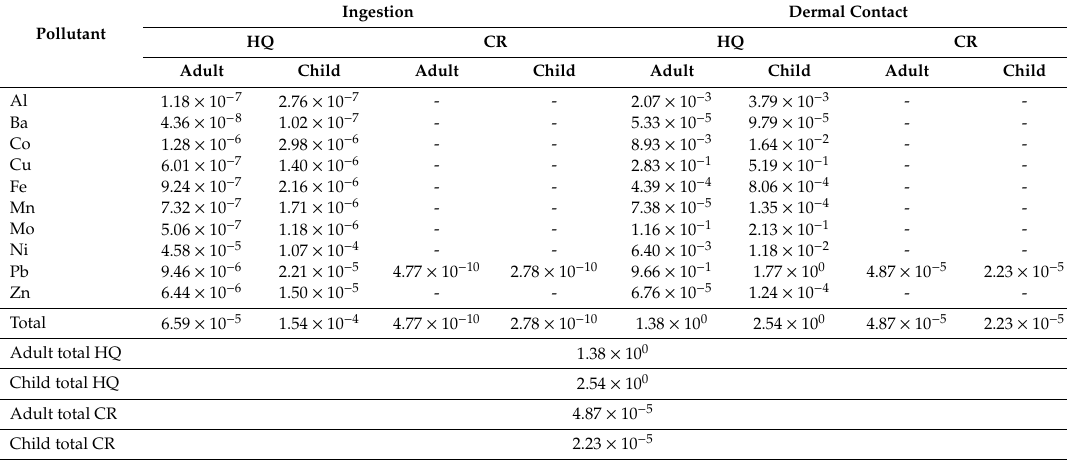
HQ—hazard quotient; CR—cancer risk; - not applicable to the available